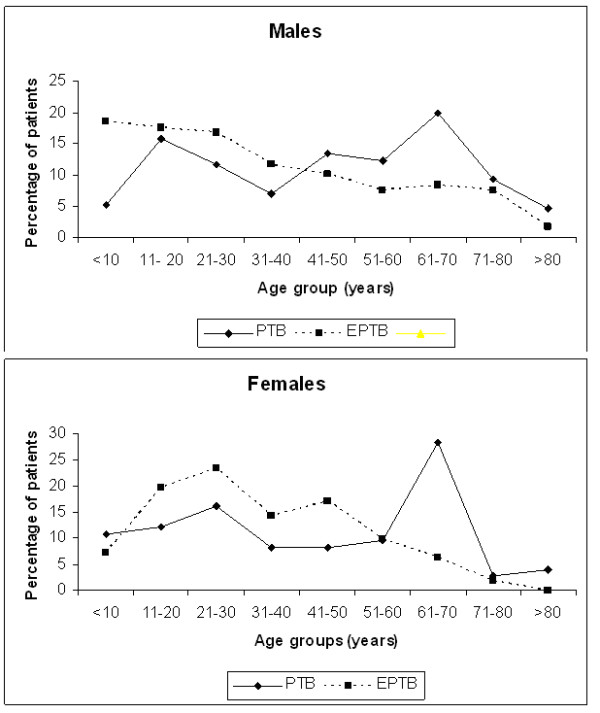
Proportional age distribution for EPTB and PTB among the 474 tuberculosis patients stratified by gender.